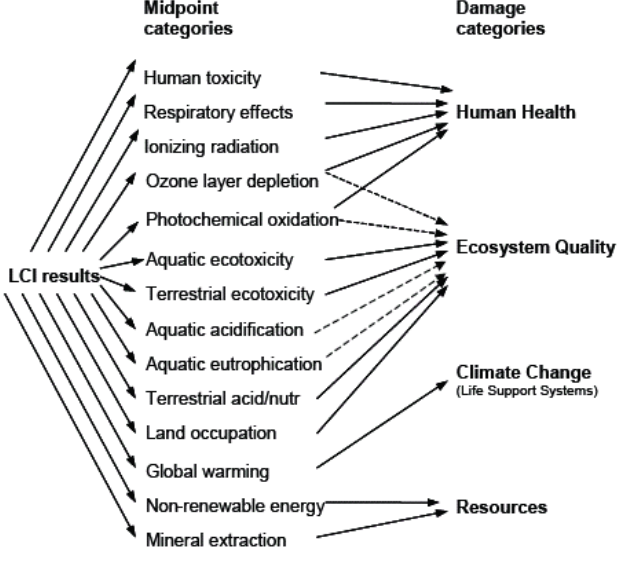
Fig. 2. IMPACT 2002+ scheme